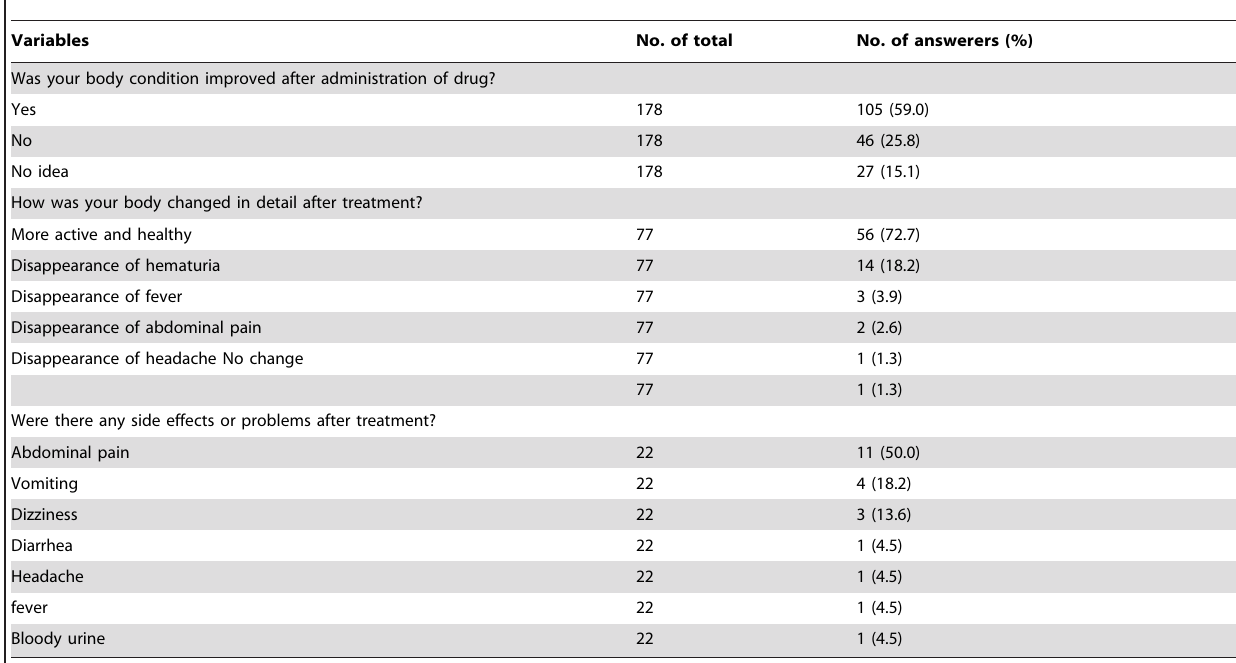
Table 9. The results of questionnaires about praziquantel treatment from school students during the Project period.